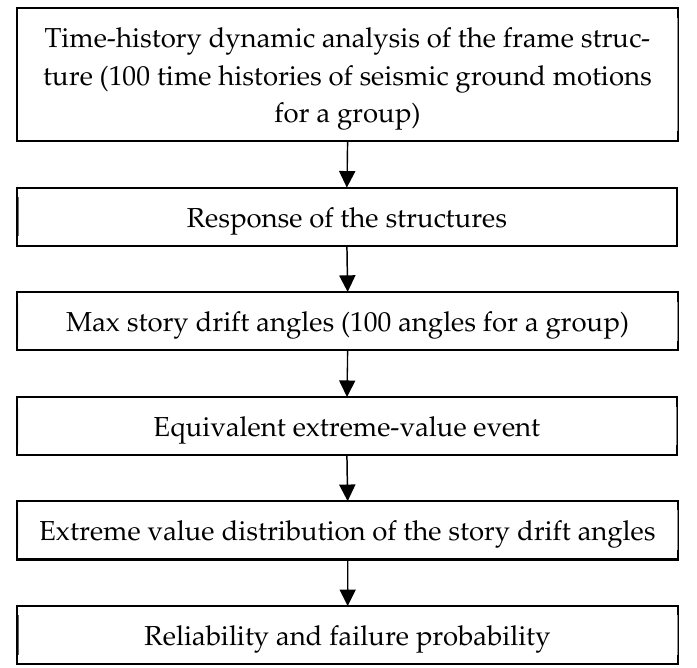
Figure 18. Computation of reliability based on the PDEM and the idea of the extreme-value event.